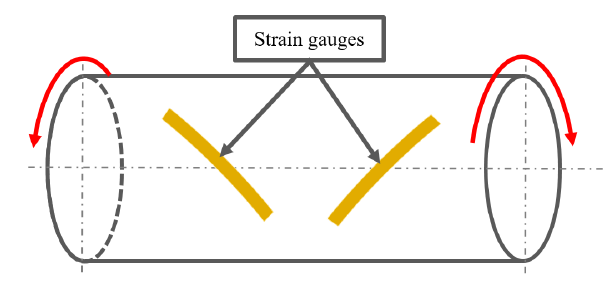
Figure 3. Torque measurement strain gauges on